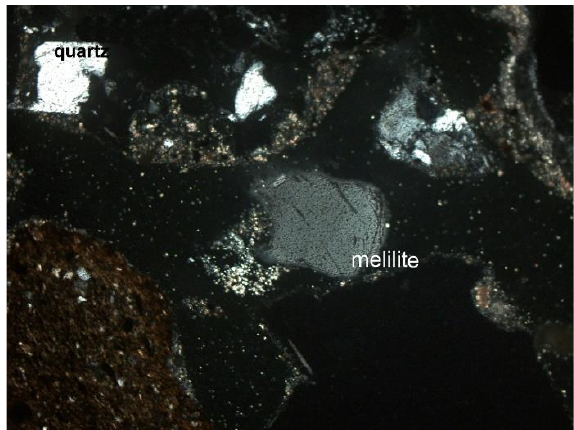
Figure 8. Melilite and quartz grains (SP1 sample), thin section, 2P, 100×, transmitted light.